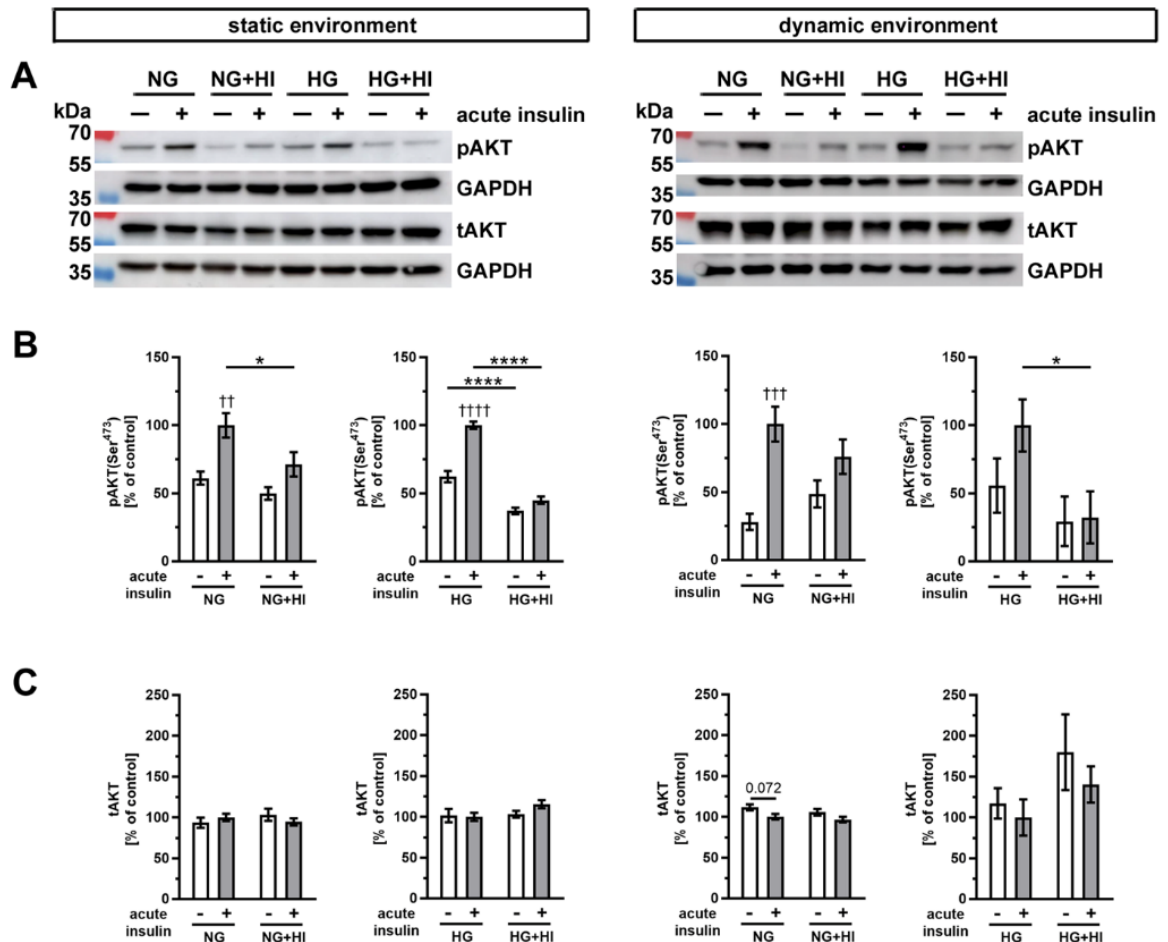
Figure 7. Activation of AKT signaling. ( A ) Representative Western blot images show the activation of AKT signaling due to diabetic cultivation conditions. Lanes of protein ladder represent 70 kDa and 55 kDa (pAKT and tAKT) as well as 35 kDa (GAPDH). ( B ) The effect of HI and HG on the insulin response of AV tissue became apparent by the phosphorylation level of AKT after acute insulin stimulation in comparison to the same condition without stimulation. The cultivation under different dynamic environments influenced the responsiveness of AV tissue to insulin. ( C ) The expression of total AKT was unaffected by the different diabetic conditions. Data were normalized to GAPDH and subsequently related to NG with acute insulin stimulus. n = 5–6; *: comparison between the indicated treatment groups; *: p < 0.05; ****: p < 0.0001; †: comparison according to the same condition without acute insulin stimulation; ††: p < 0.01; †††: p < 0.001; ††††: p < 0.0001; kDa: kilodalton; pAKT: phosphorylated protein kinase B; tAKT: total protein kinase B; GAPDH: glyceraldehyde 3-phosphate dehydrogenase; NG: normoglycemia; HI: hyperinsulinemia; HG: hyperglycemia.